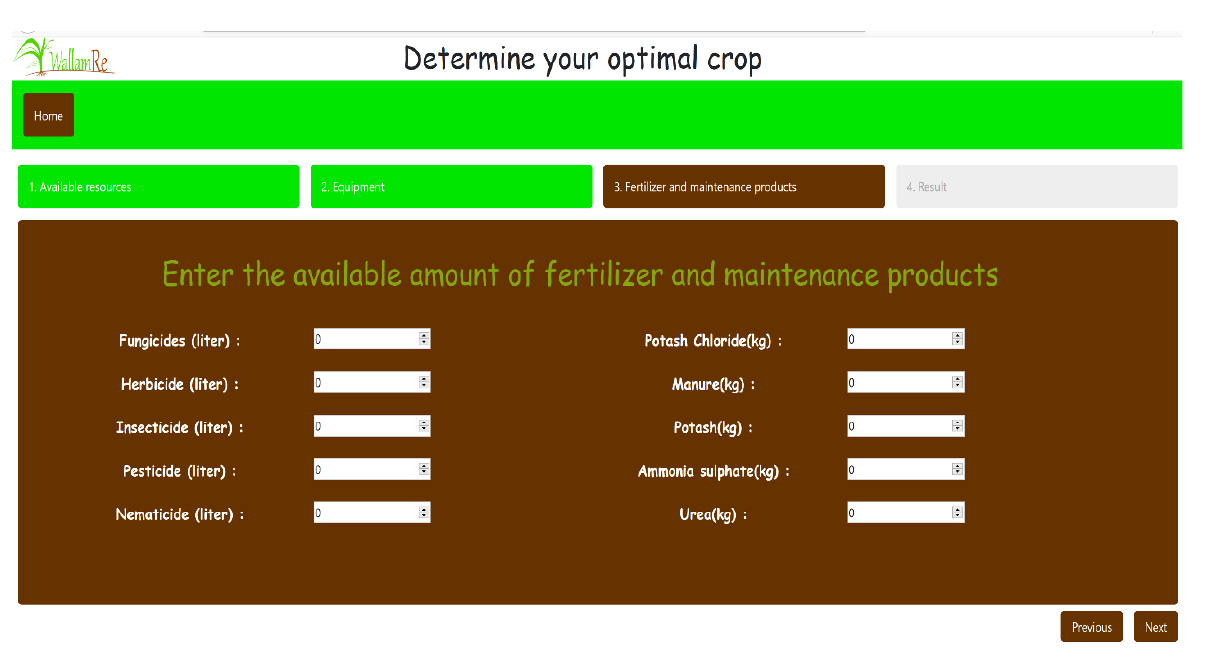
Figure 8. Interface to enter available fertilizer and maintenance products